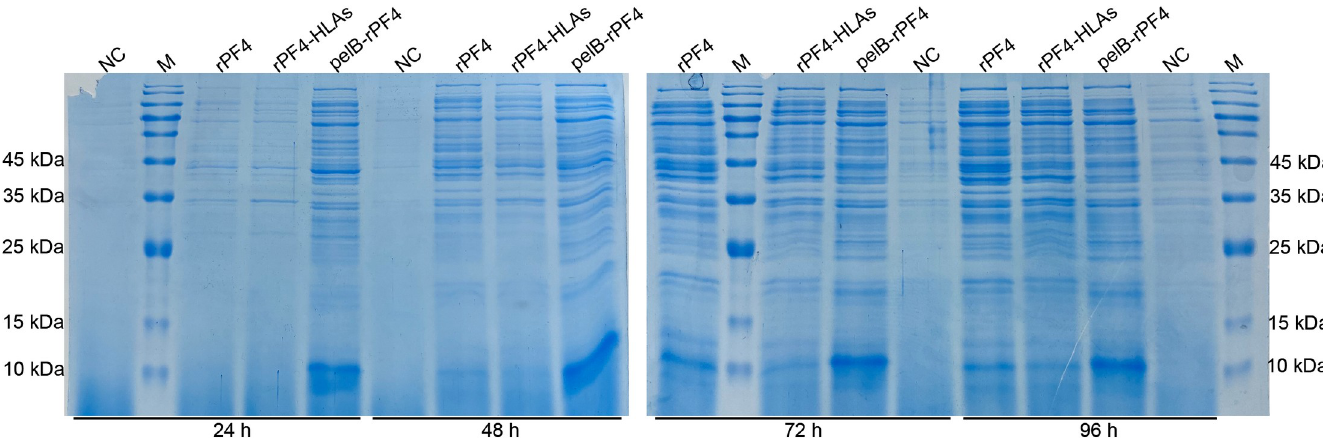
Fig 8. Investigating the stability of the secreted rPF4 as a function of time. The lanes labeled by rPF4, pelB-rPF4 and rPF4-HLAs refer to proteins expressed from the pET26b-rPF4, pET26b-pelB-rPF4 and pET26b-rPF4-HLAs constructs, respectively. Bacteria harboring the pelB-rPF4 were found to secrete the highest amount of rPF4. The secretion seems to be stable until 48 h, and no considerable increase in the rPF4 secretion was observed beyond 48 h. The background secretion from the pET26b- rPF4 construct started to increase after 48 h and seems to be due to the cellular rupture as a result of excessive cultivation or sample preparations (for instance, the centrifugation step). NC indicates the negative control and the M denotes the molecular weight